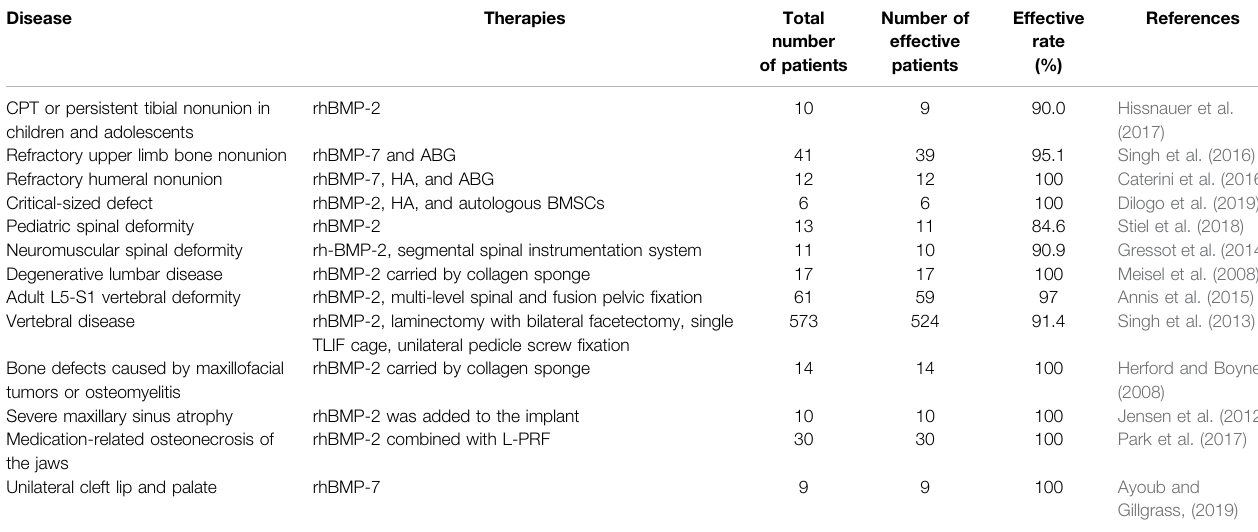
TABLE 5 | Clinical applications of